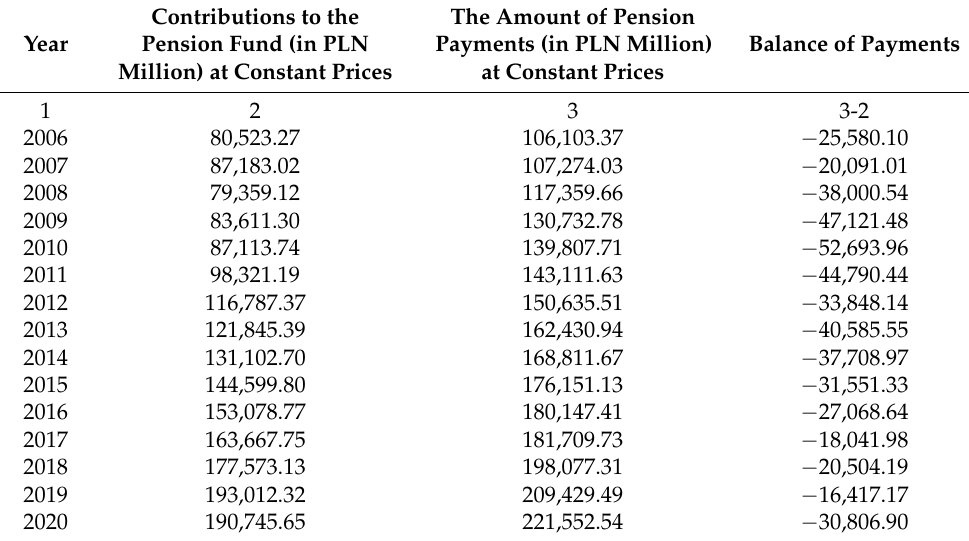
Table 2. Contributions to and withdrawals from the Pension Fund